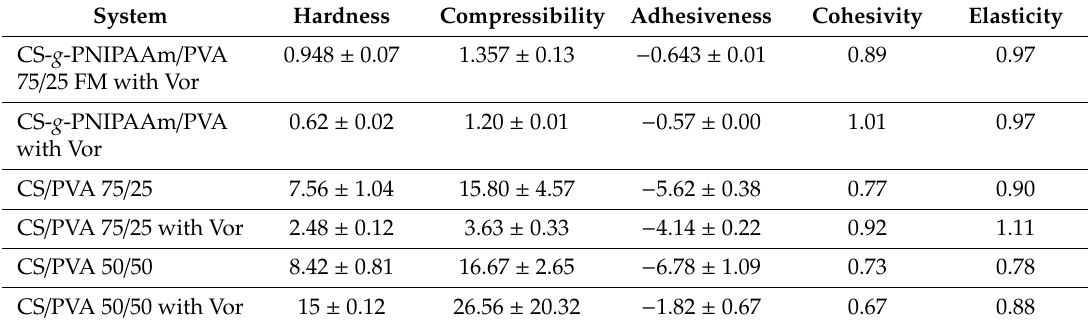
Table 2. Texture profile analysis (TPA) results for the gels obtained for the pre-formulation studies. System Hardness Compressibility Adhesiveness Cohesivity